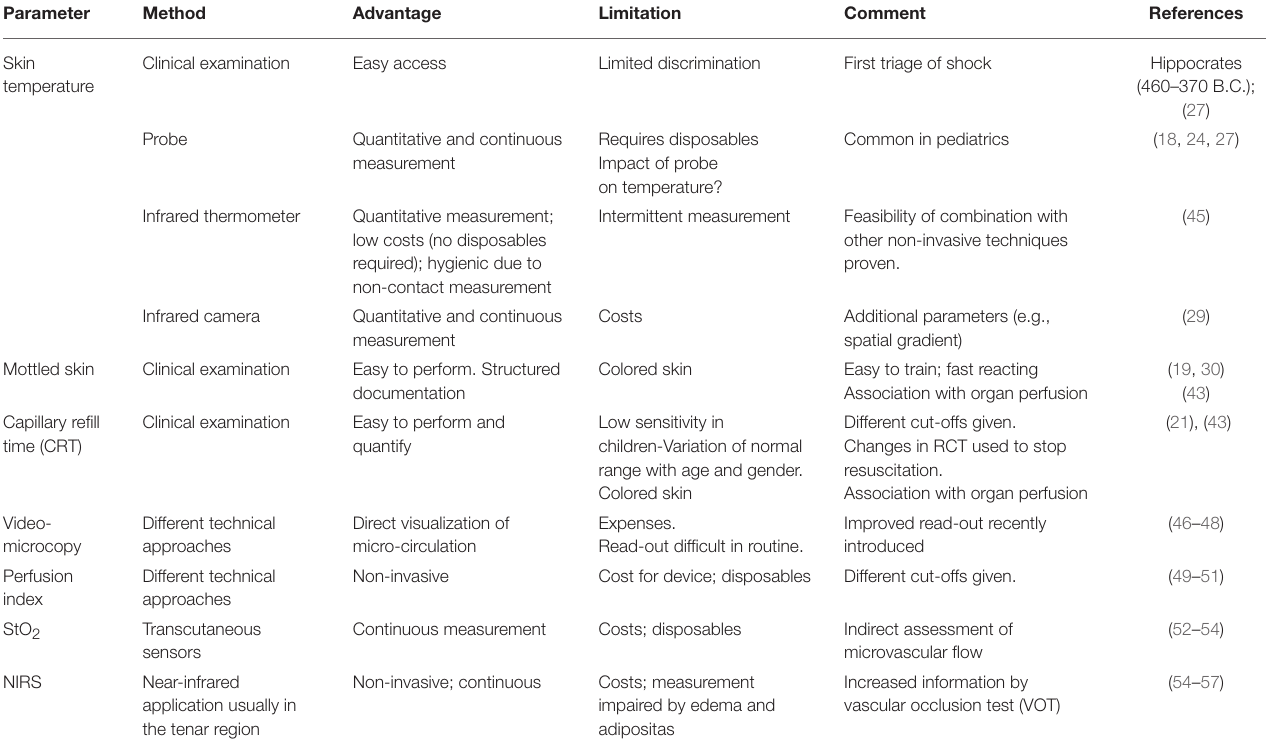
TABLE 4 | Clinical and technical approaches to assess micro-circulation [modified according to Tafner et al. (36)].